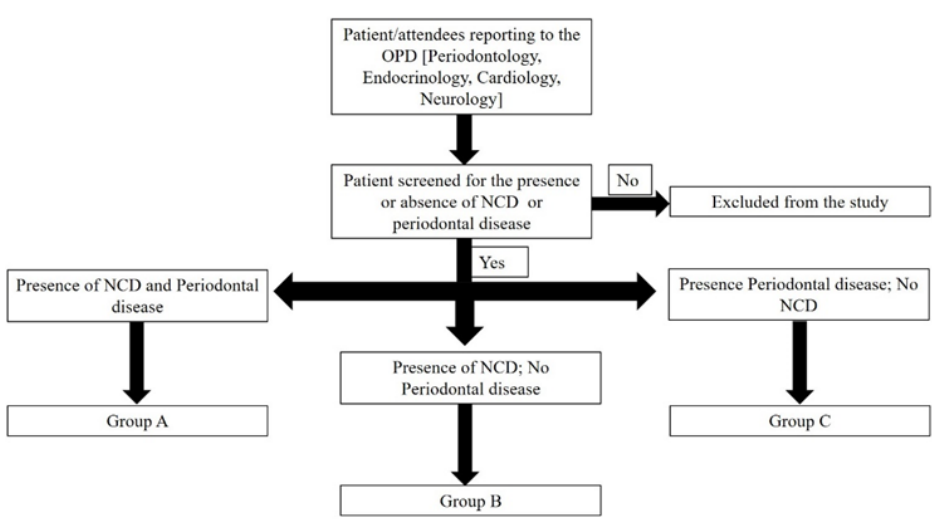
Figure 2. Participant selection – decision tree .